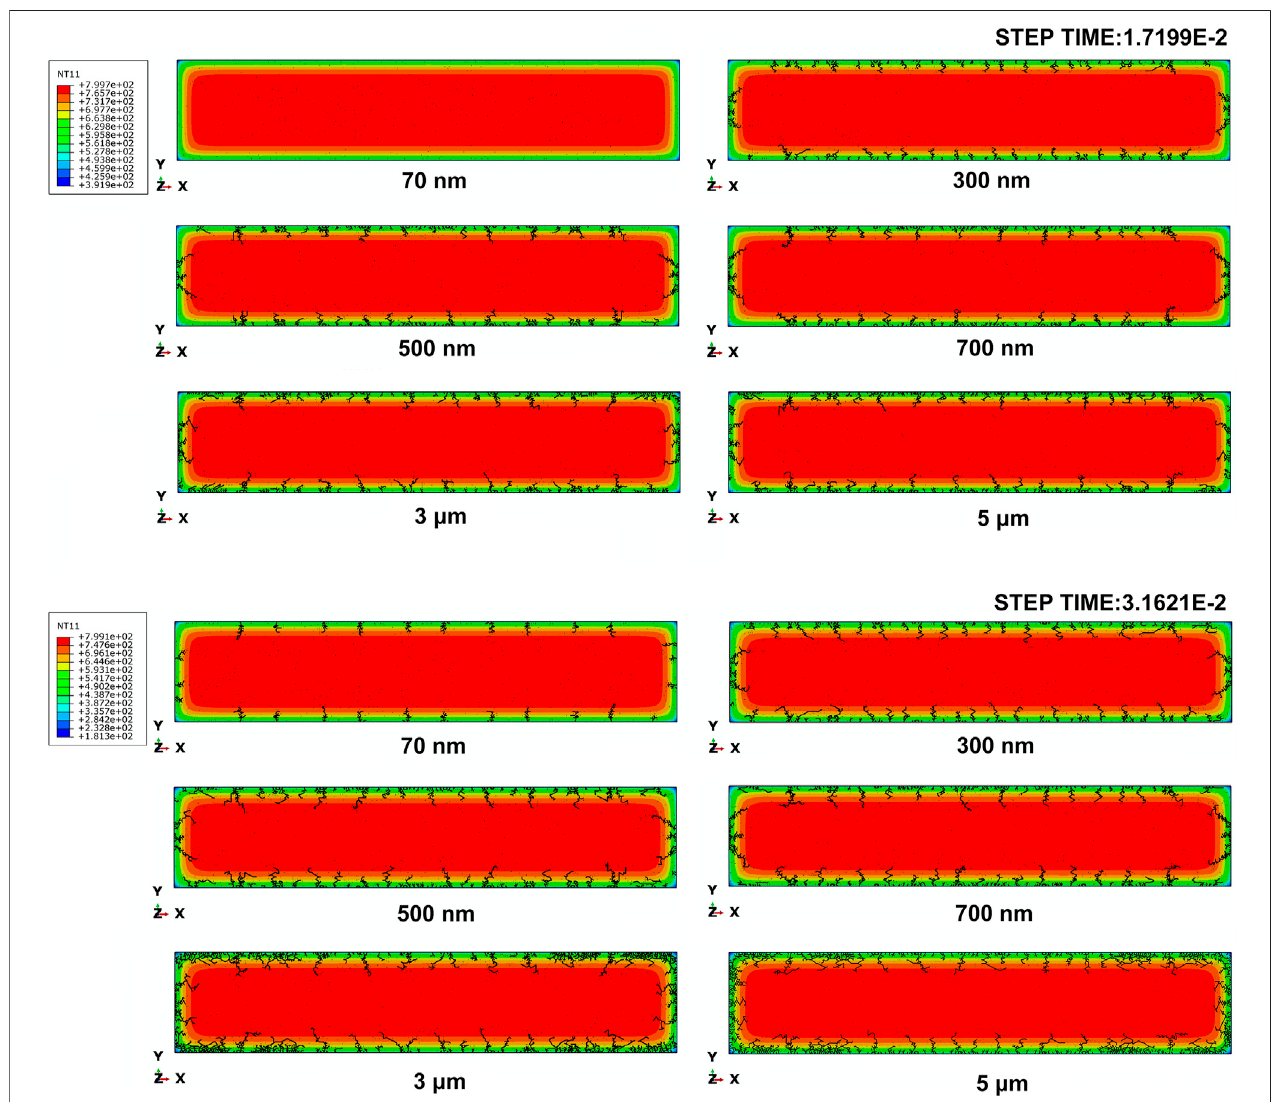
FIGURE 4 | Crack pattern for different grain sizes at step time 1.7199 E − 2 and step time 3.1621 E − 2 with T 0 (cid:2) 800 ° C.